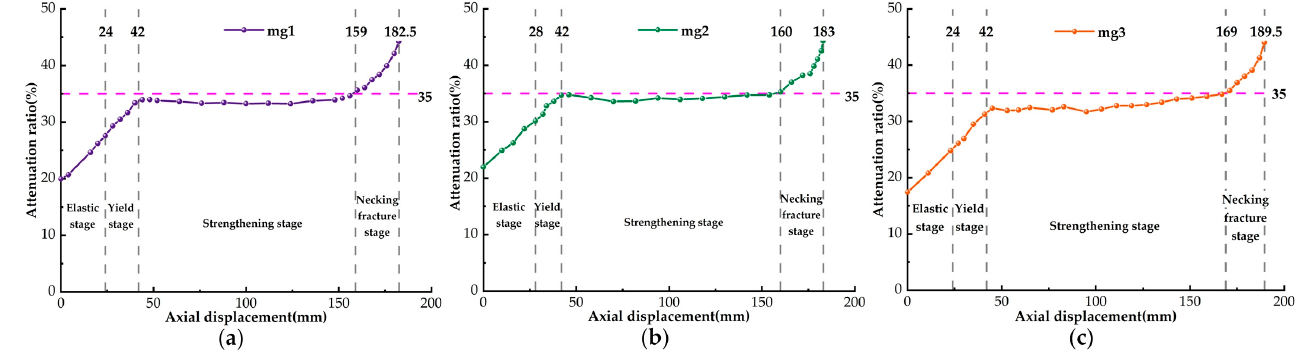
Figure 11. Stress wave energy attenuation ratio of bolt tension process. ( a ) mg1; ( b ) mg2; ( c ) mg3.